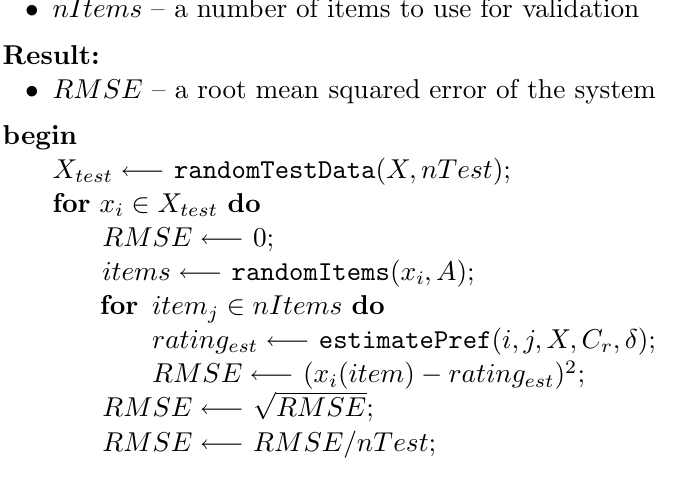
Algorithm 2: The procedure of evaluation of the recommender system